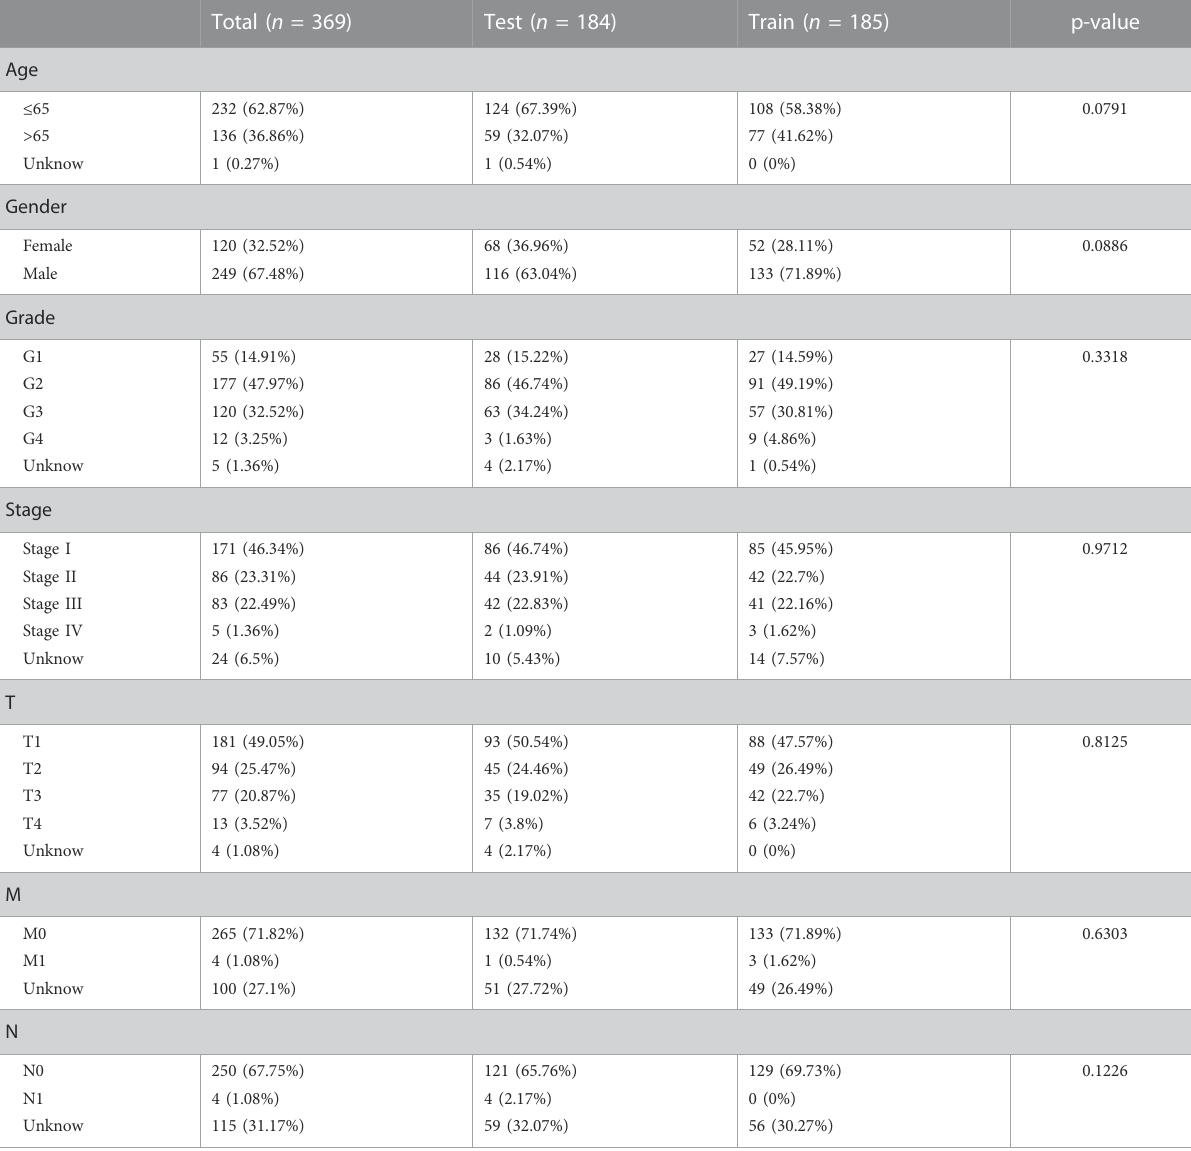
TABLE 1 The baseline data of three